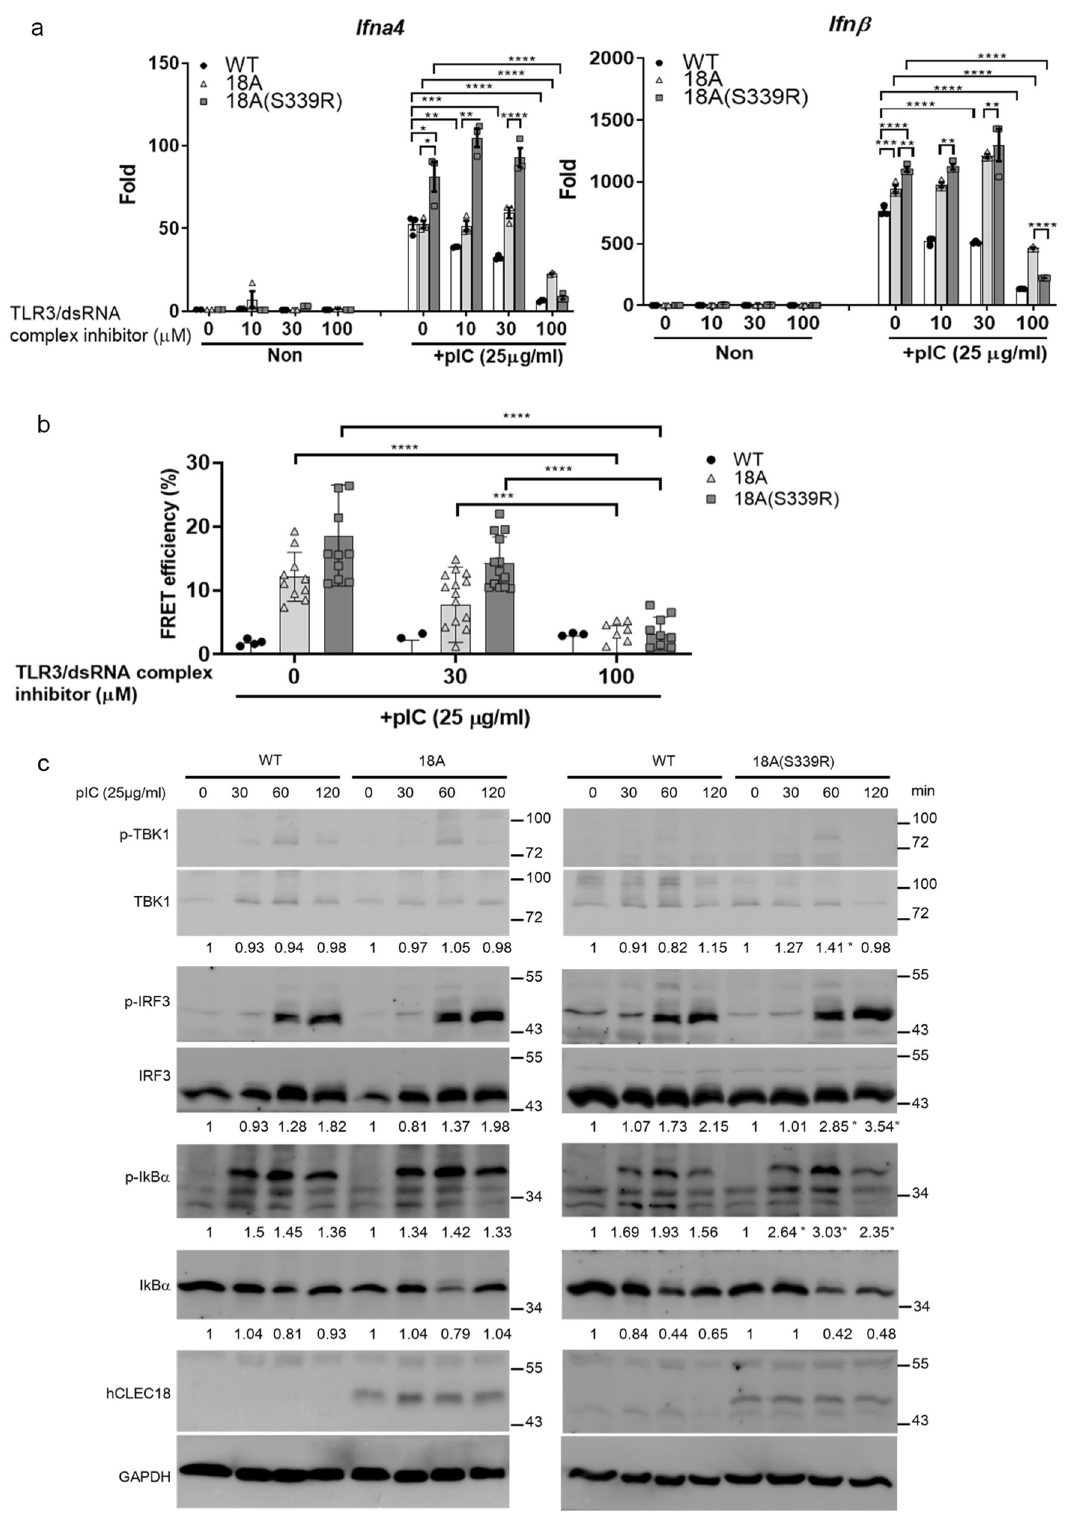
Fig. 5 CLEC18A and CLEC18A(S339R) enhance TLR3-mediated signaling and IFN production. a BMDMs (1 × 10 6 /well) from WT and CLEC18 KI mice were preincubated with various concentrations of TLR3/dsRNA complex inhibitor for 1 h, followed by the addition of HMW poly (I:C) (25 μ g/ml) for 12 h before harvesting samples to determine cytokine expression by RT-PCR ( n = 3). b Alternatively, BMDMs (3 × 10 4 /well) were preincubated with various concentrations of TLR3/dsRNA complex inhibitor for 1 h, followed by the addition of HMW poly (I:C) (25 μ g/ml) for 2 h for FRET assay ( n = 3 – 8). c BMDMs (2.5 × 10 6 /well) were incubated with HMW poly (I:C) and then lysates were harvested at indicated time points, followed by harvesting samples to analyze protein phosphorylation by WB. pIC poly (I:C), min minute ( n = 3). * P < 0.05, ** P < 0.01, *** P < 0.001 and **** P <